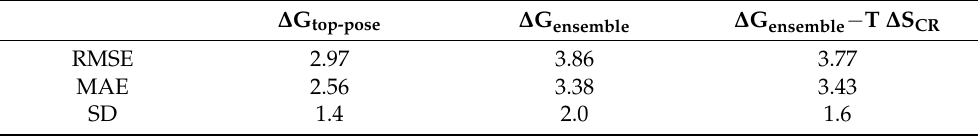
Table 3. Error of GFN2-xTB CB[8]*(G0–G9) calculated ligand binding free energies in